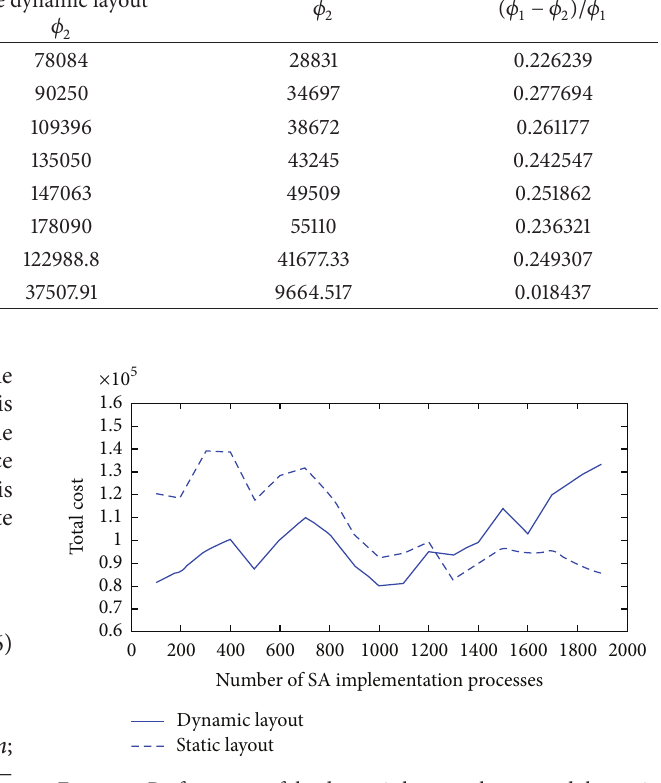
Figure 7: Performance of the dynamic layout schemes and the static ones with relocation cost ranging from 100 to